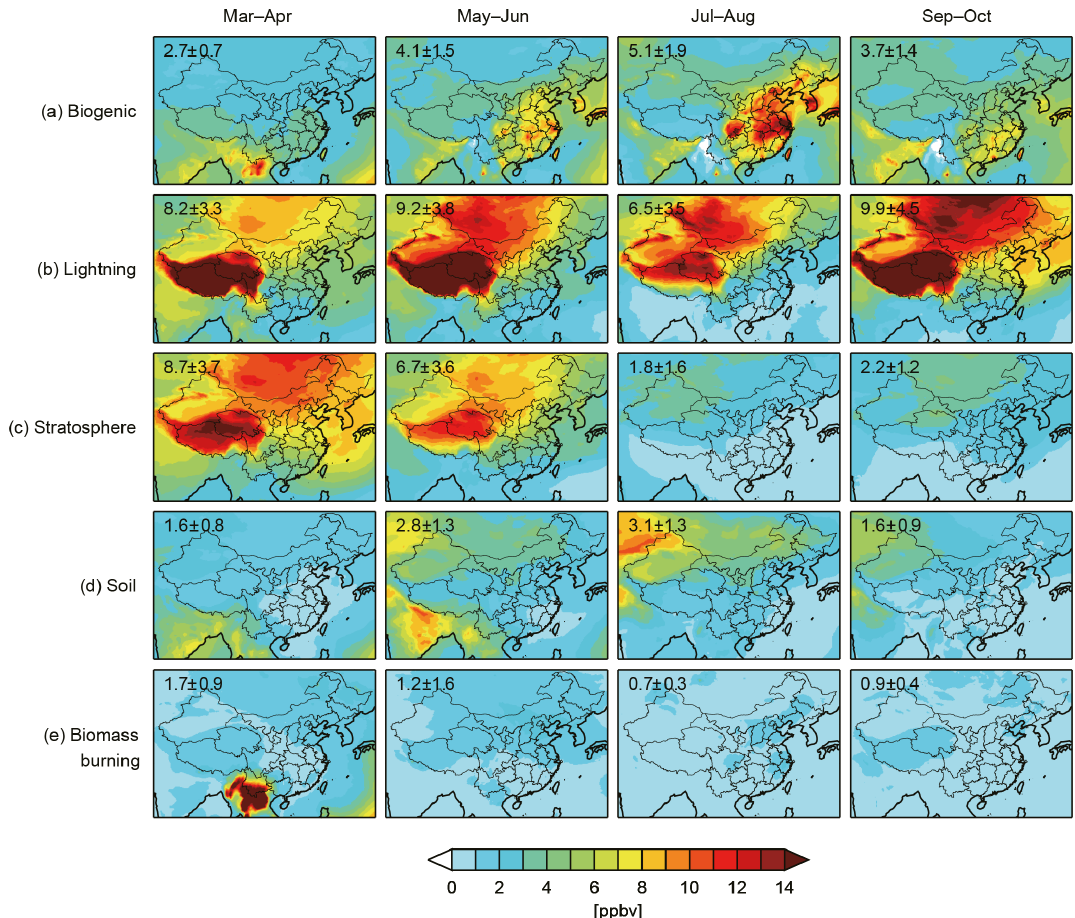
Figure 4. Same as Fig. 3 but for ozone enhancements from (a) biogenic volatile organic compound emissions, (b) lightning NO x emis- sions, (c) the stratosphere, (d) soil NO x emissions, and (e) biomass burning emissions. The source attributions are diagnosed as the differ- ence between the BASE simulation and a simulation with the specific source turned off, expect for ozone from the stratosphere, which is diagnosed by the TagO 3 simulation as described in the